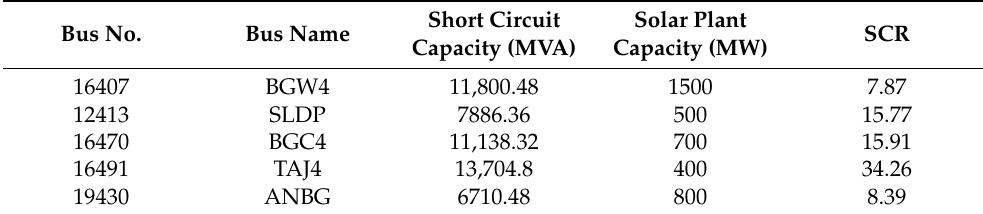
Table 5. Added solar power capacity and SCR evaluation. Bus